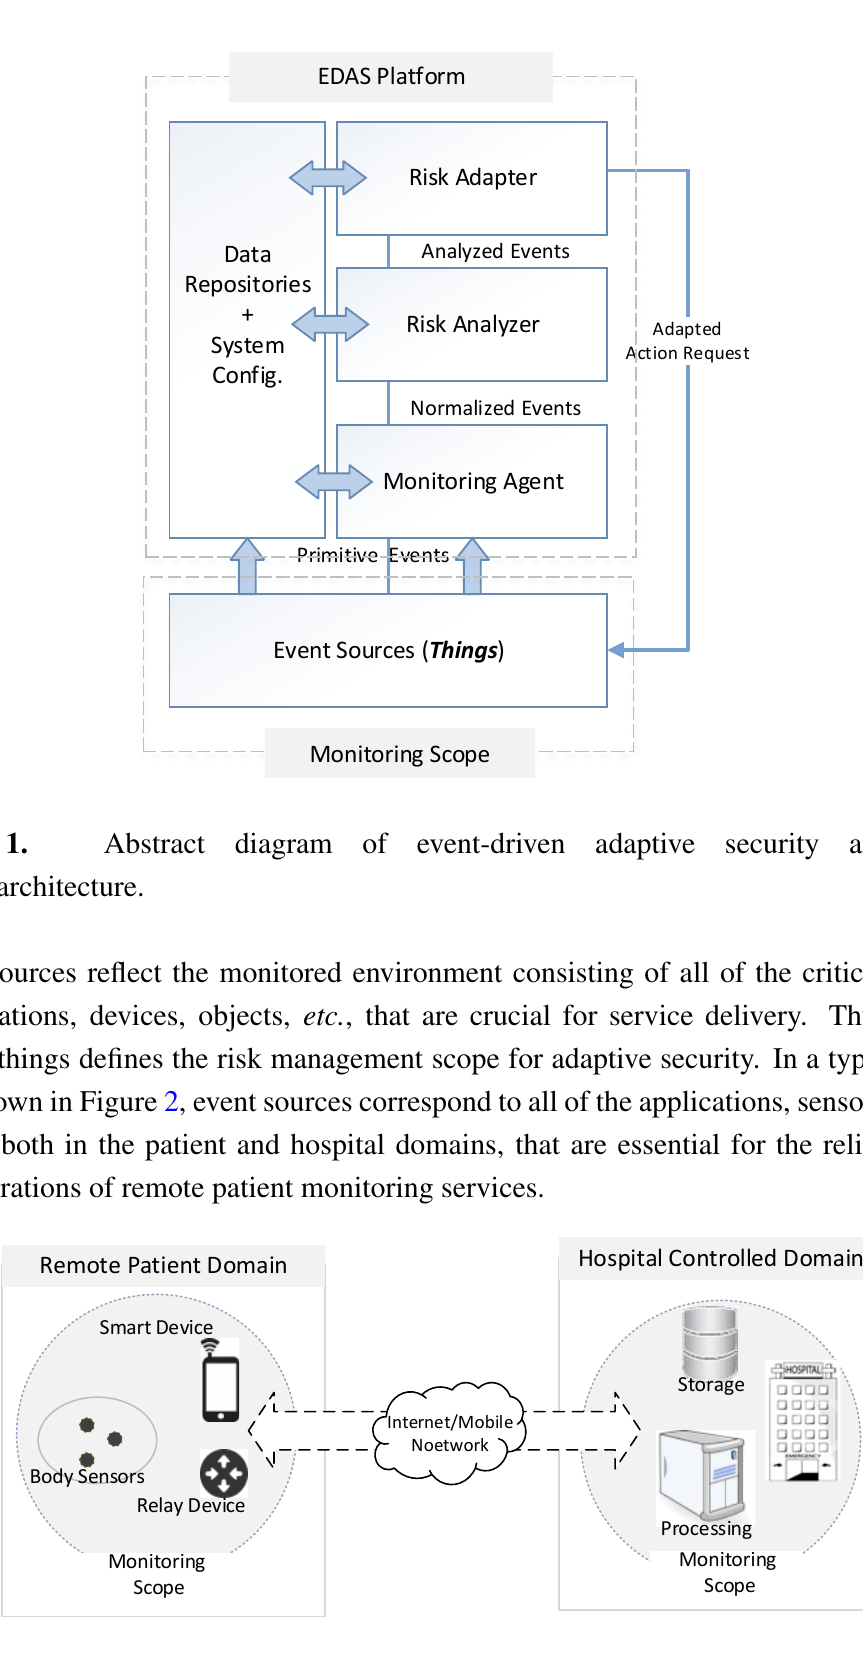
Figure 2. IoT-eHealth